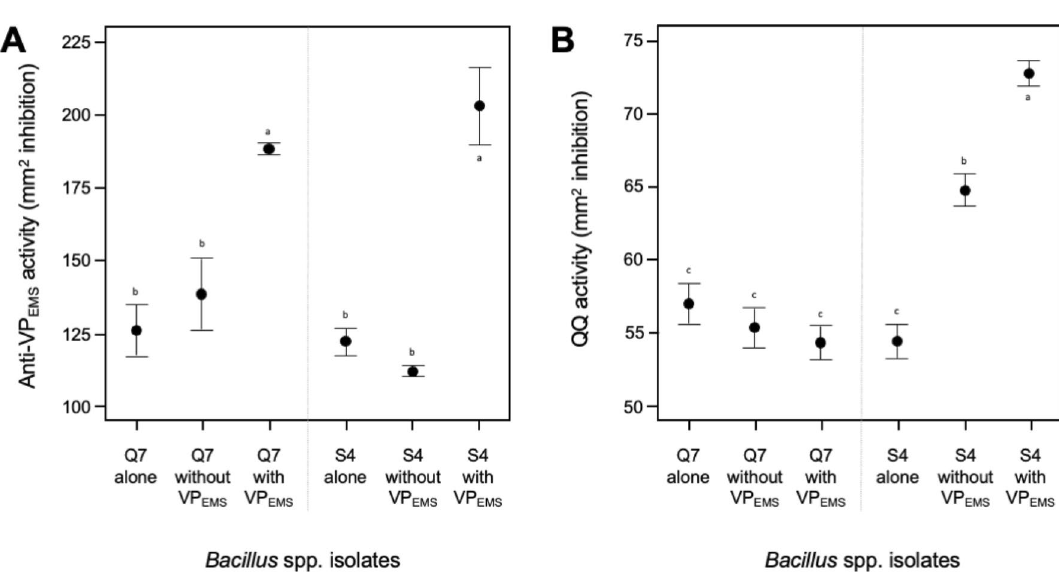
Figure 7. ( A ) Anti-VP EMS activity (in mm 2 inhibition) and ( B ) quorum quenching activity (in mm 2 inhibition) for both Q7 and